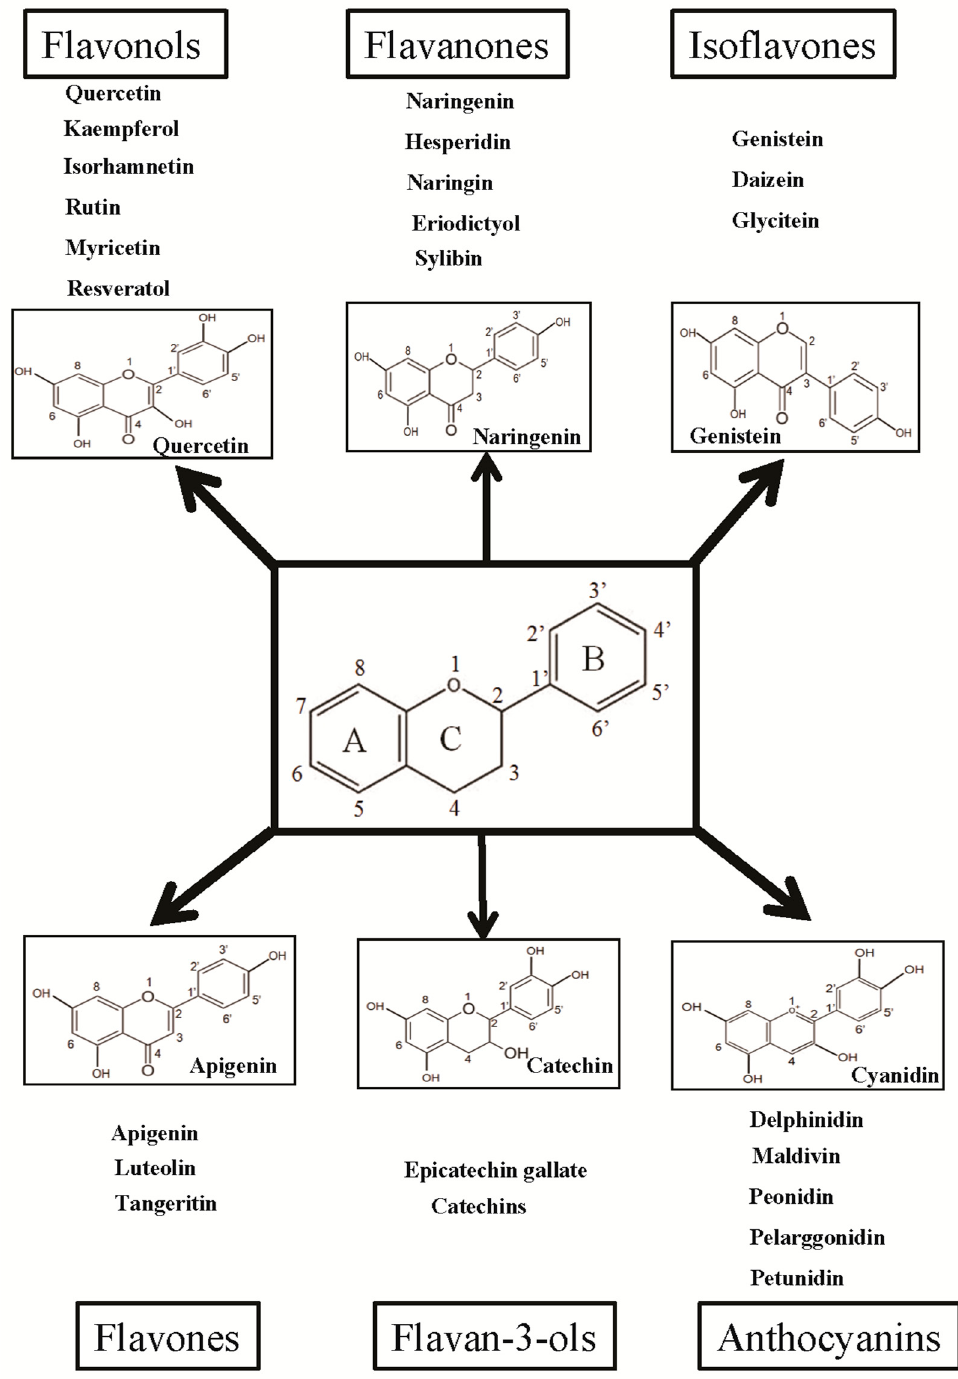
Figure 2. Classification and example of flavonoids and their chemical structures. Flavonoids are classified into six groups, including flavonol, flavanone, isoflavone, flavone, flavan-3-ols, and anthocyanin. Chemical structures of each of the six classes of flavonoids are shown as examples, including isorhamnetin for flavonol, naringin for flavanone, daizein for isoflavone, apigenin for flavone, catechin for flavov-3-ols, and cyanidin for anthocyanins.